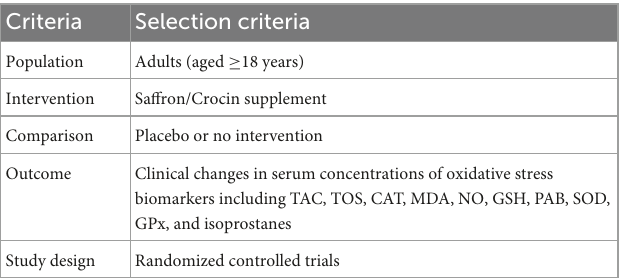
TABLE 1 The population, intervention, comparison, outcome, study design (PICOS)